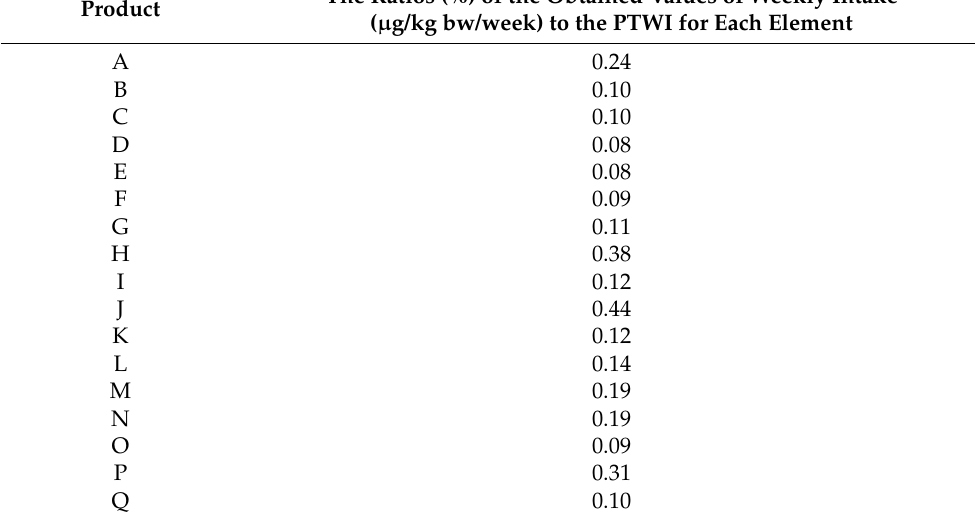
Table 9. The percentages (%) of the acquired values for Se of weekly consumption ( µ g/kg bw/week) to the established